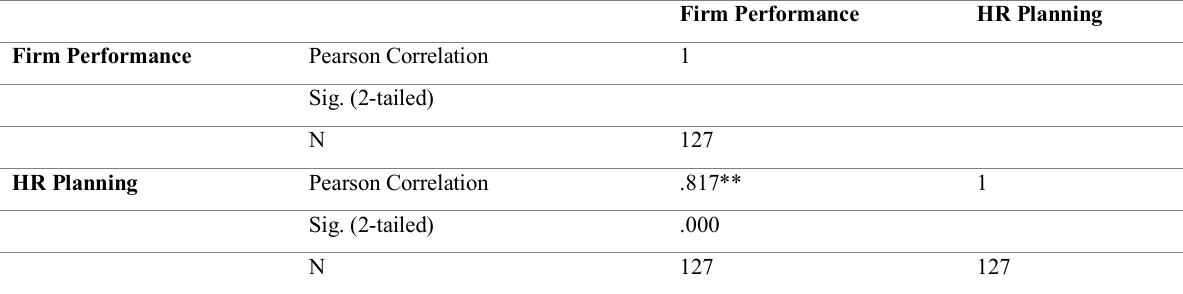
Table 3: Correlation Analysis between human resource planning and firm